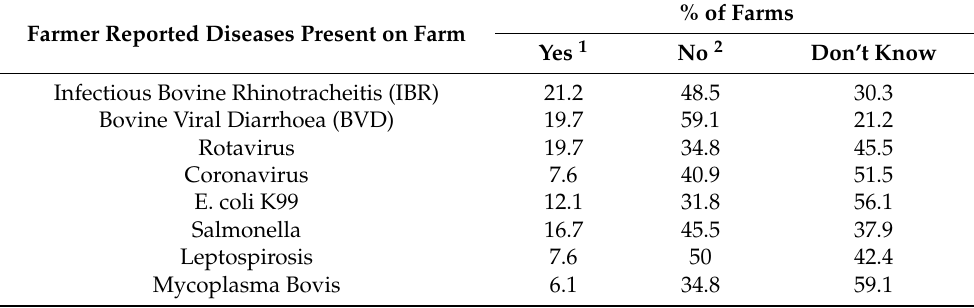
Table 6. Farm disease status.